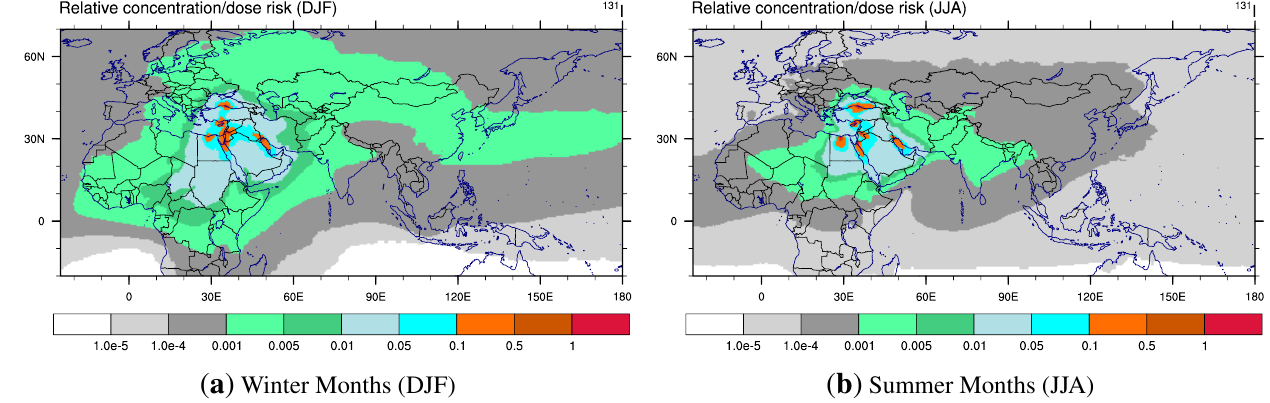
Figure 7. Relative seasonal risk by 131 I (mean surface layer concentration) from potential NPP accidents and equivalent effective dose to the public from inhalation in the EMME region for the winter ( a ) and summer months ( b